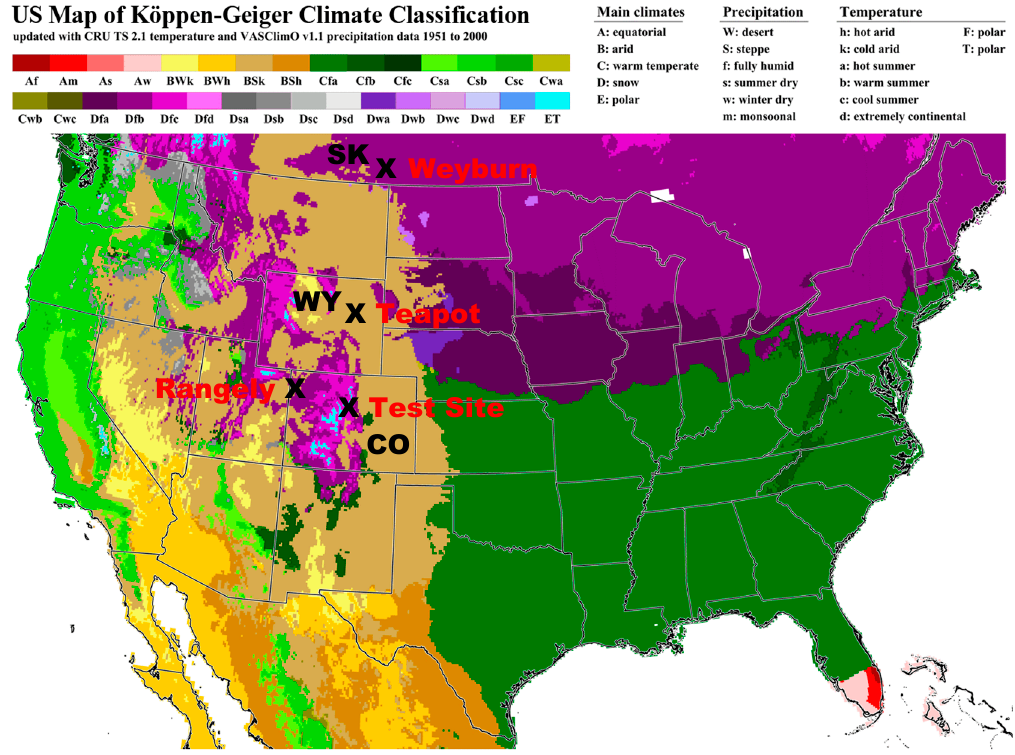
Figure 1. Location of sites of measurements and discussion in this study (modified from http://koeppen-geiger.vu-wien.ac.at/usa).